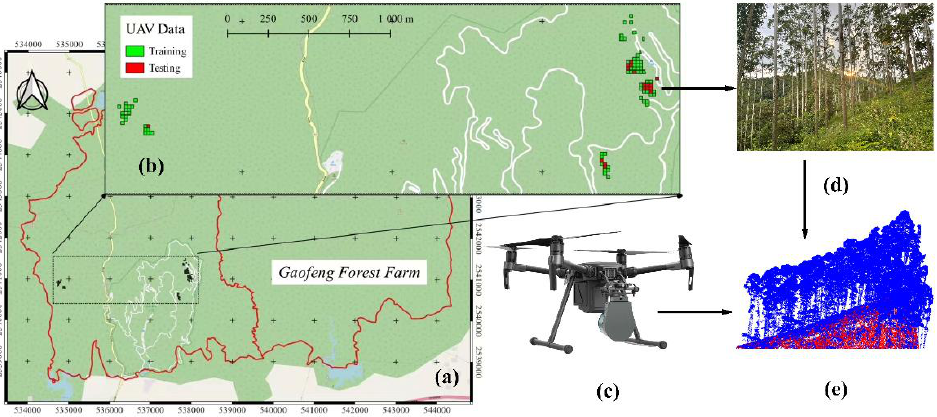
Figure 1. Illustration of the forest farm location ( a ), the distribution of the UAV LiDAR data tiles ( b ), the model diagram of the UAV LiDAR scanner and the UAV platform carrying the LiDAR ( c ), the picture of the real forest plots( d ), and a sample of the UAV point cloud ( e ).